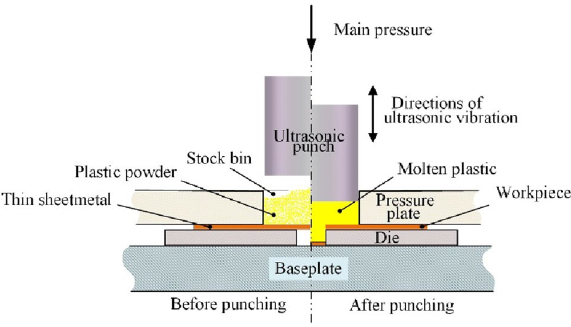
Figure 1. Schematic diagram of Micro-USF forming